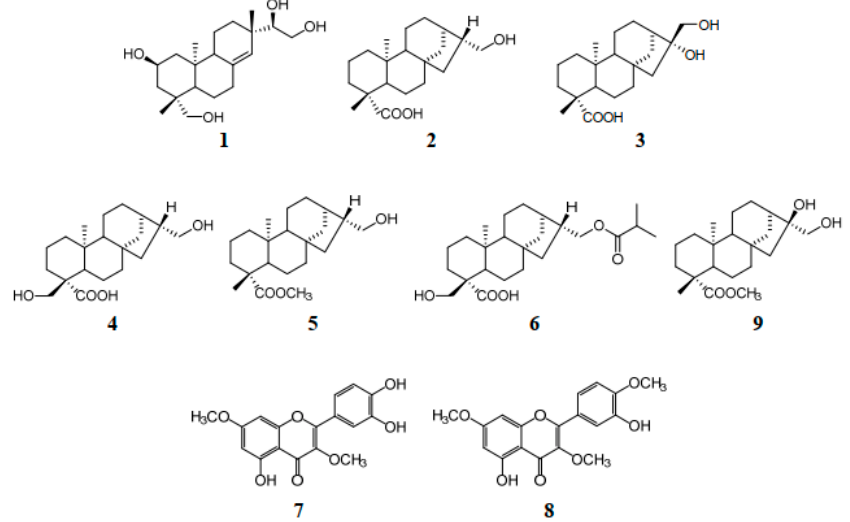
Figure 3. Chemical structures of compounds isolated from S. glabrescens .